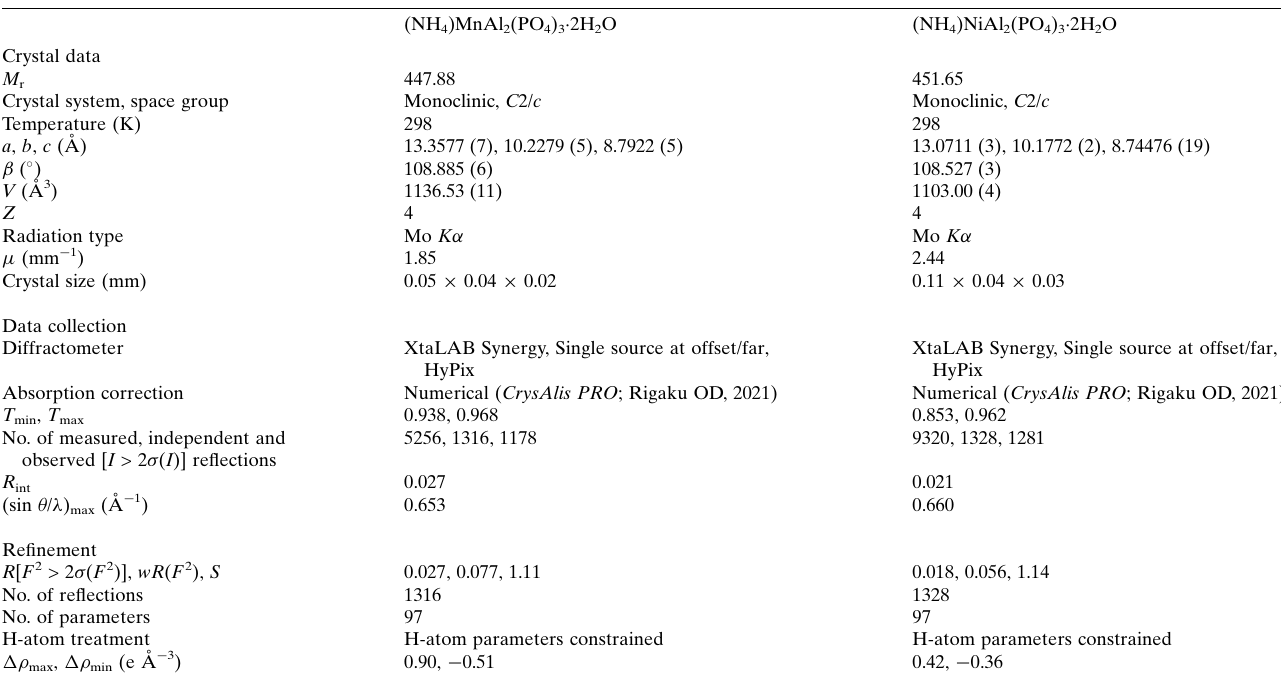
Table 4 Experimental